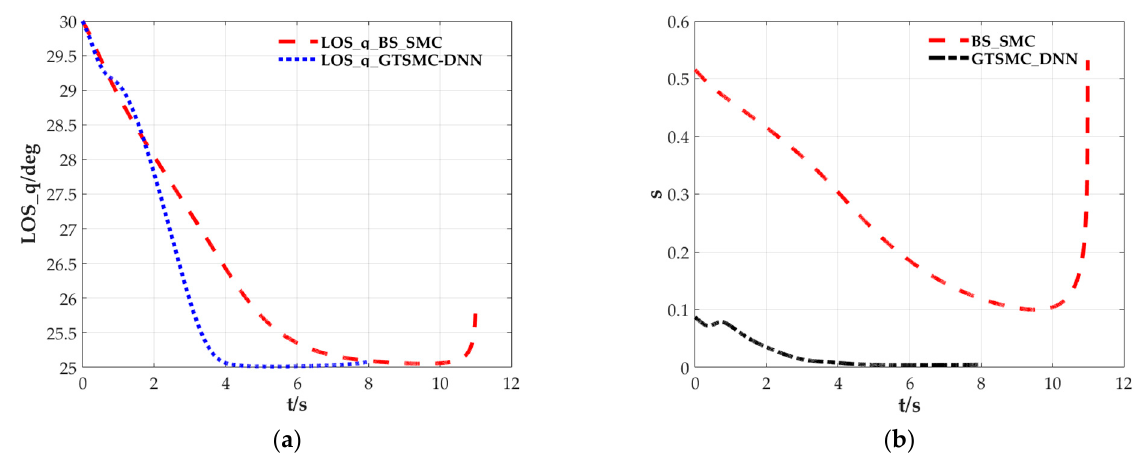
Figure 10. ( a ) System states of LOS angle; ( b ) The sliding mode surface.